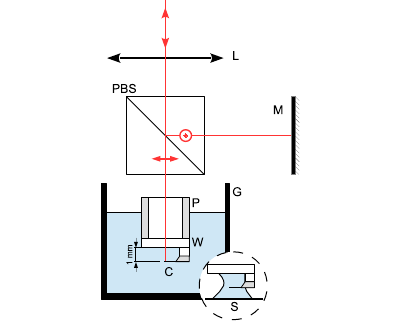
Figure 2. Using a polarized beam splitter (PBS), the input beam is divided in two, with crossed polarizations as shown in the divided laser beam. An external mirror (M) reflects the reference beam and provides fine control of the overlap of the returned beams. A lens (L) focuses the probe beam at the free end of the cantilever (C). The reflected beams, probe and reference are superposed after the PBS. Interferences are obtained after projecting the initial polarizations in the analysis area (see [19] for details). The sensing beam path is protected by a stainless steel pipe (P). An optical quality window (W) ensures the transition from air to liquid with minimum refraction and undesirable reflections in order to reach the free end of the cantilever (C). The liquid is contained in a Pyrex glass (G). Inset: the micro-droplet configuration uses a microscope slide to support a liquid drop ( 50 µ L ). The micro-cantilever is fully immersed, and the space between the window (W) and the microscope slide (S) is filled with the fluid, forming a meniscus. In order to prevent beam distortion, the window W is of laser quality with suitable anti-reflection